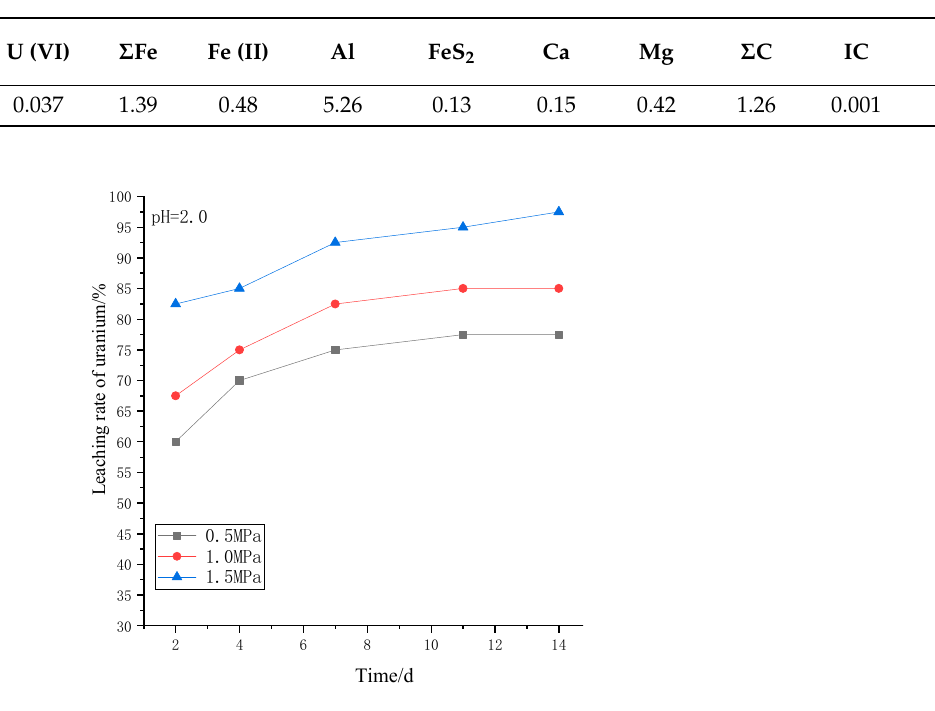
Table 3. Chemical analysis data of ore sample.